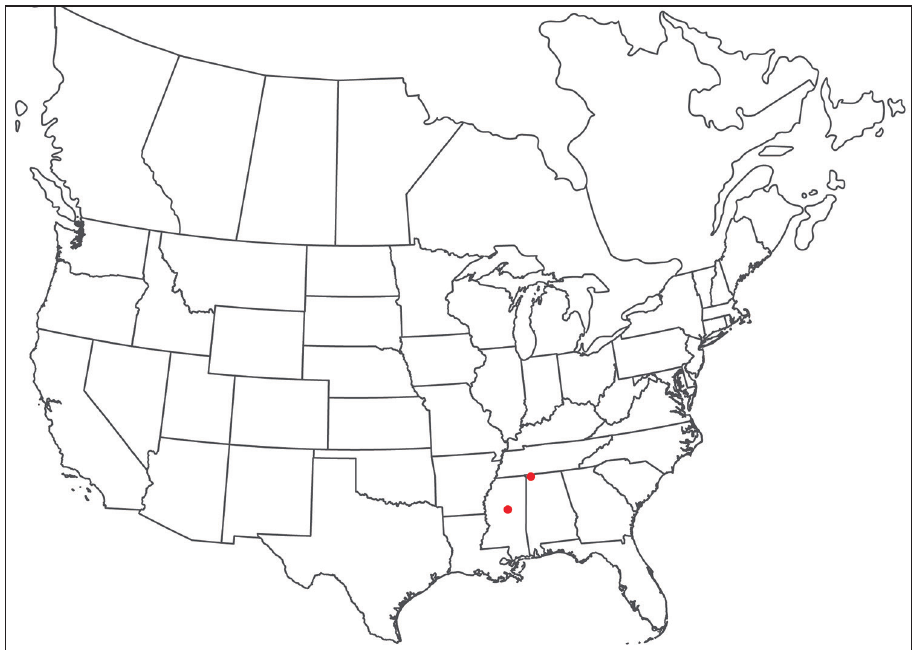
Figure 261. Torrenticola ululata sp. n.